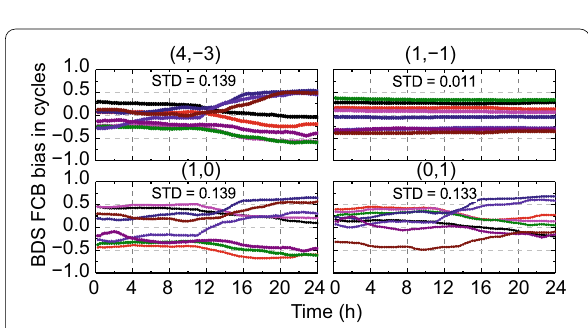
Fig. 8 BDS-2 FCBs series for the (4, individuals of each frequency. Each color denotes one satellite FCB